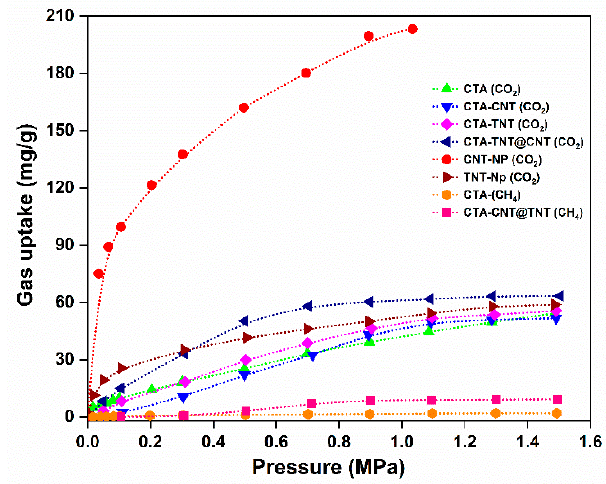
Figure 7. Pure CO 2 and CH 4 gas uptake capacity of the synthesized MMMs. The dotted lines are a guide for the